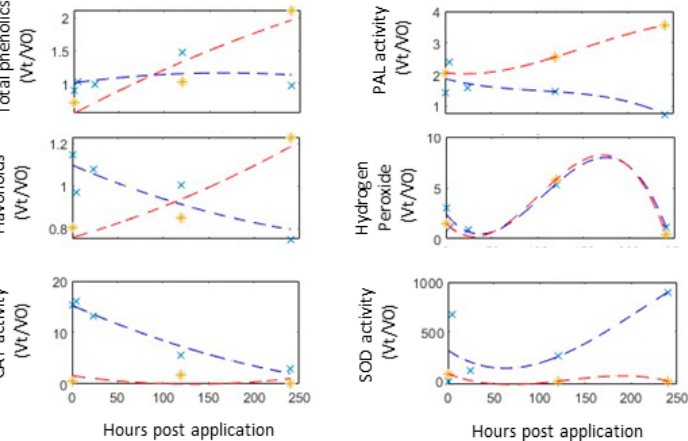
Figure 6. Mathematical modeling of plant immune responses to non self eDNA (mixed plants eDNA) applied in adult plants. Data showed in normalized dimensionless values for each sampling time in hours post treatment application. Blue lines represent responses to first application and red lines represent responses to second application of treatment.